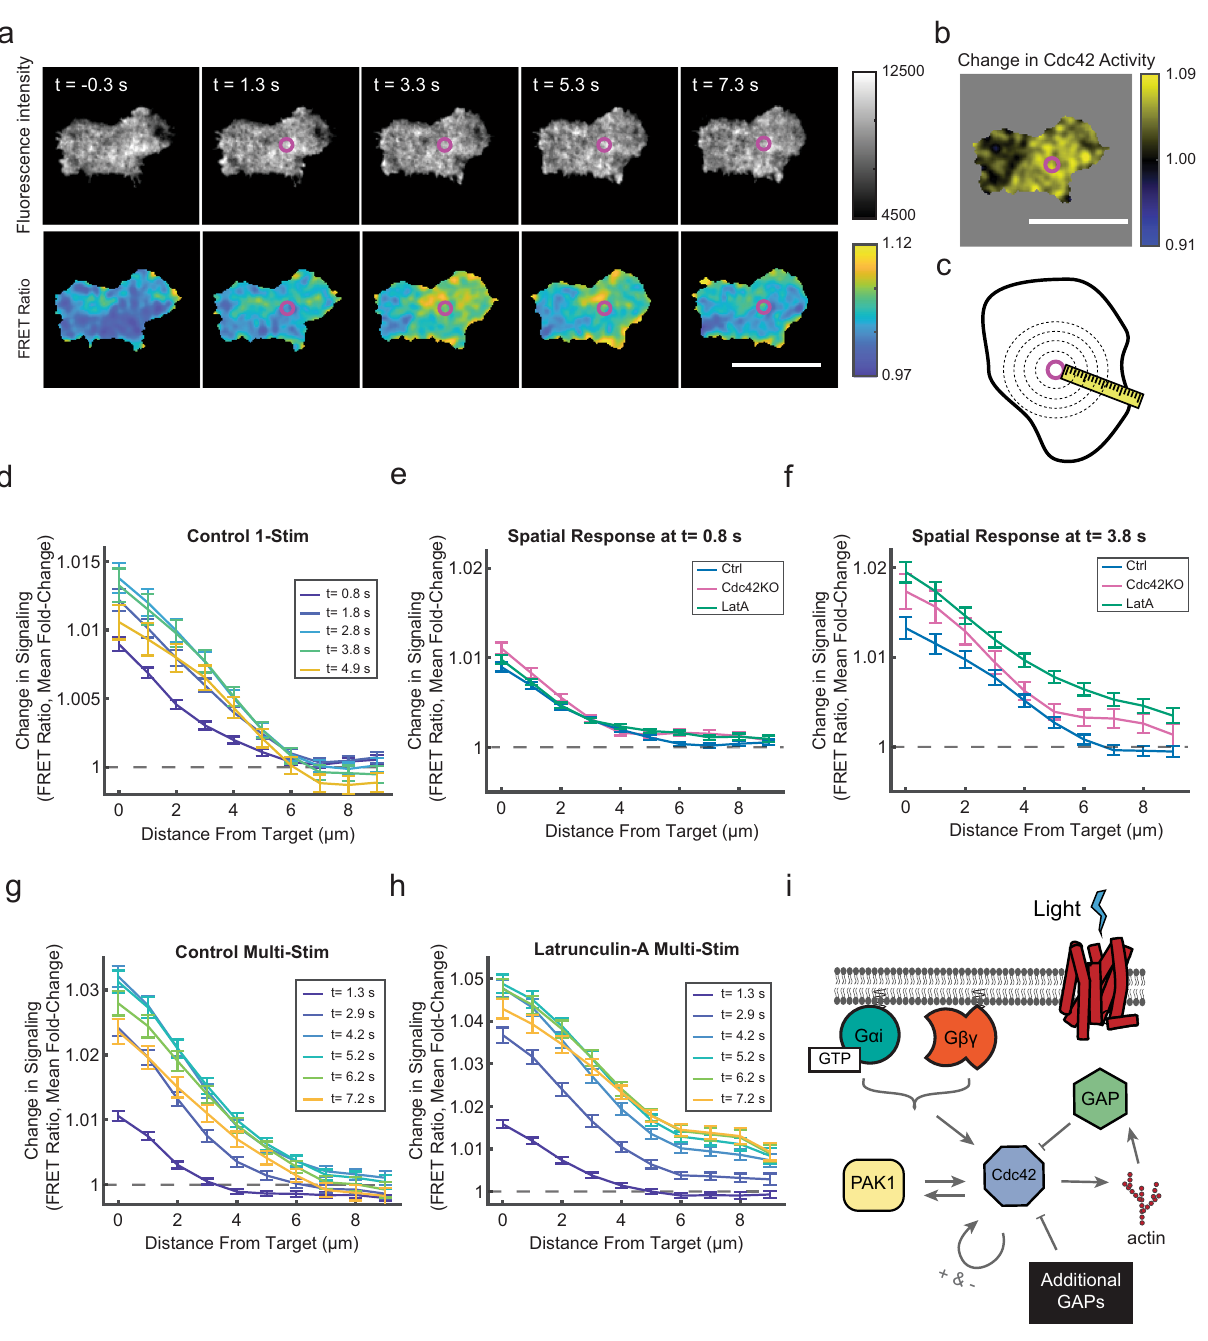
Fig. 7 F-actin and Cdc42 spatially constrain the spread of signals downstream of receptors. a A control cell responding to the center-stimulation experiment. A single laser pulse (4.3 µ W, 10 ms duration) was applied between frames 1 and 2. The purple circle indicates the stimulation site. Top panel images are the sum of the two FRET channels. Bottom panel images are FRET ratio images. Times relative to stimulation are indicated. Scale bar, 15 µ m. Micrographs are representative of n = 131 cells. b The spatial Cdc42 response was calculated as fold change between the FRET ratio images before and after stimulation (Frame 3/Frame 1) for the cell shown in ( a ). Scale bar, 15 µ m. The image is representative of n = 131 cells. c Schematic for center- stimulation experiment analysis strategy. Cell pixels were aggregated based on their distance from the stimulus target site (magenta circle) for each frame in the experiment. d Relative Cdc42 response as a function of distance from the stimulus target site for control cells at the indicated time points. One 0.8 µ W light pulse of 10 ms duration was delivered at t = 0 s. Data are presented as mean ± s.e.m. ( n = 181 cells). e , f Relative Cdc42 response as a function of distance from stimulus target site for control, Cdc42-KO, and Latrunculin-A conditions at t = 0.8 s ( e ) and t = 3.8 s ( f ) post stimulation. Data are presented as mean ± s.e.m. ( n = 181 cells for control, n = 67 for Cdc42-KO, and n = 175 for Latrunculin-A-treated cells). g , h Relative Cdc42 responses as a function of distance from the stimulation site for control and Latrunculin-A conditions in response to fi ve sequential 0.8 µ W light-pulses of 10 ms duration delivered immediately after successive images, with the fi rst stimulus delivered at t = 0 s. Data are presented as mean ± s.e.m. ( n = 142 cells for control and n = 102 for Latrunculin-A-treated cells). i Schematic indicating the positive and negative regulators of the Cdc42 response identi fi ed in this study. Source data are provided as a Source Data fi